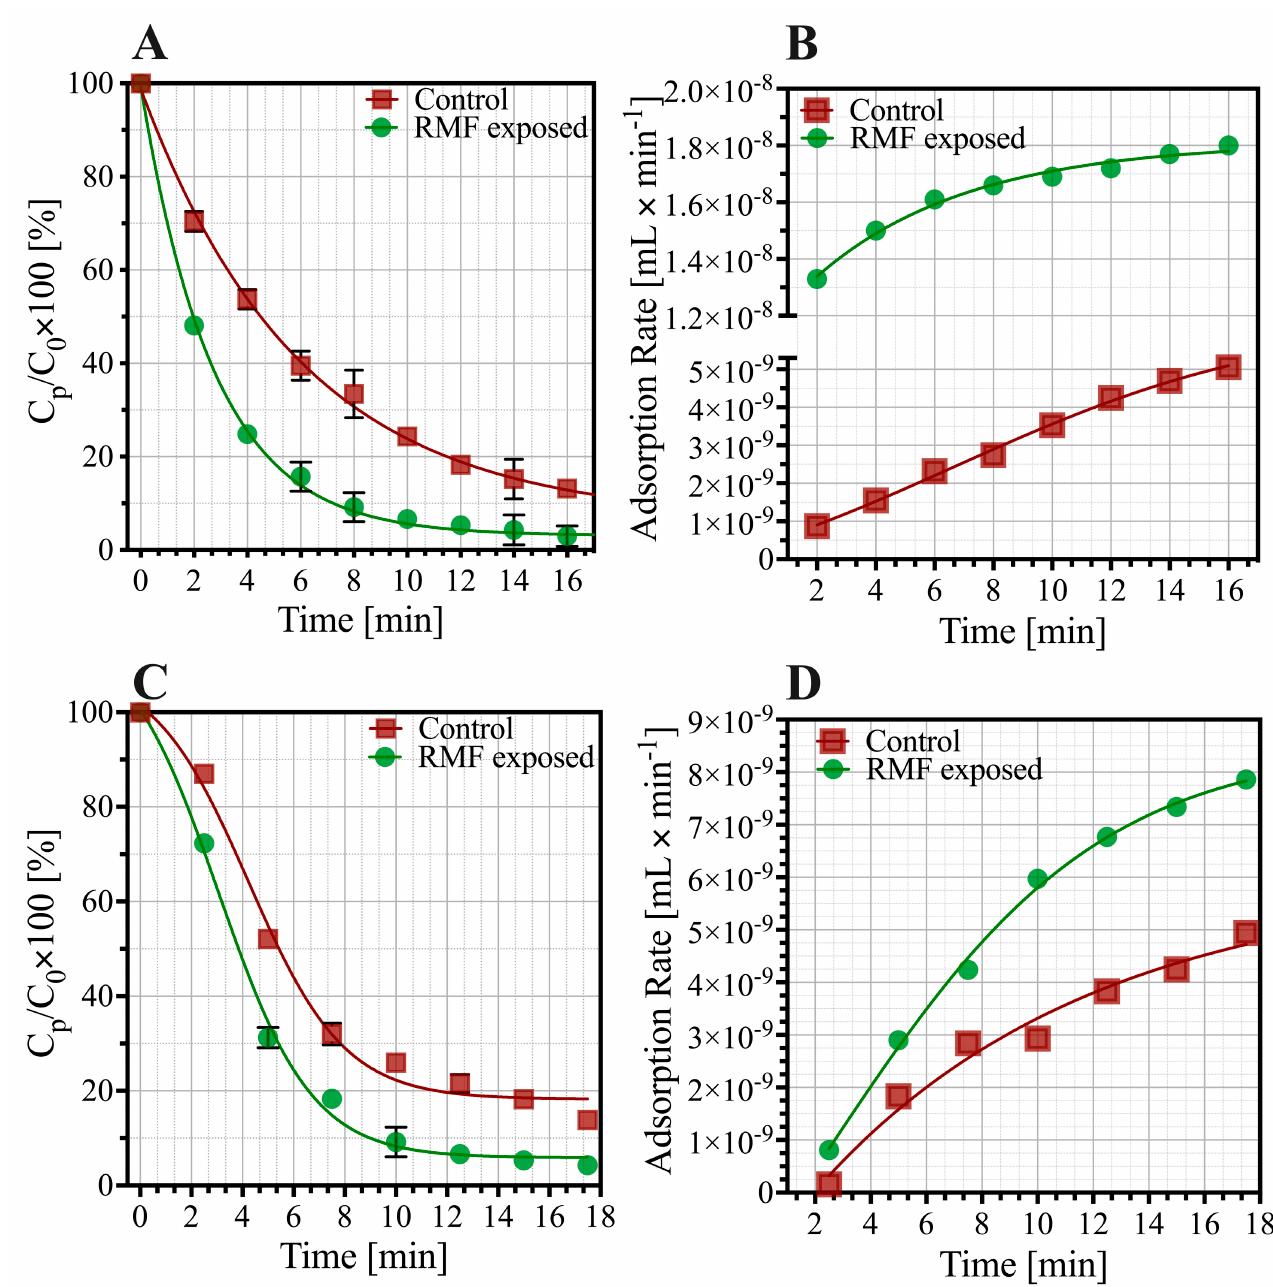
Figure 2. Influence of the RMF on bacteriophage adsorption process: ( A ) the percentage of unab- sorbed T4 bacteriophages under control (red) and RMF exposed condition (green); ( B ) adsorption rate curves of RMF-exposed and unexposed bacteriophage T4; ( C ) the percentage of unabsorbed vB_SauM_A bacteriophages under control and RMF exposed condition ( D ) adsorption rate curves of RMF-exposed and unexposed vB_SauM_A. C p —number of phages on timepoint, C 0